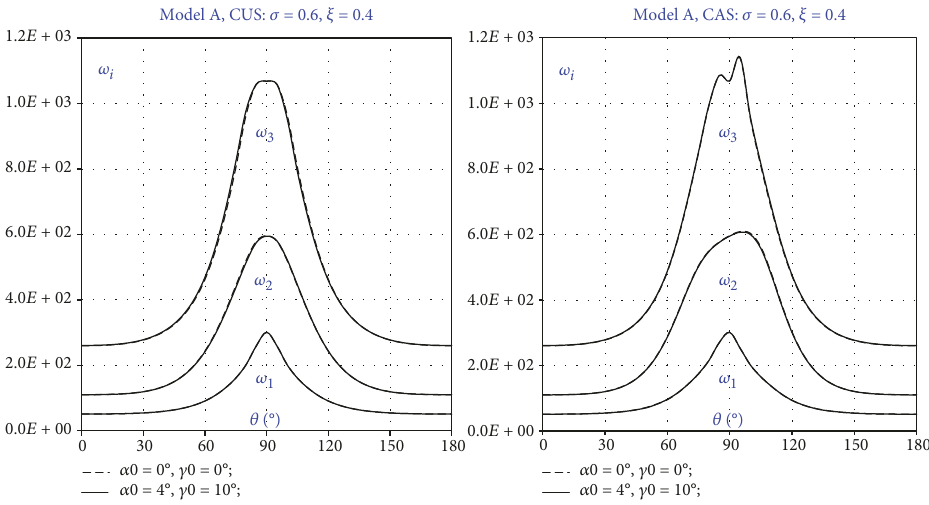
Figure 10: Eigenfrequencies vs. ply angle of Model A via α Table 7: Eigenfrequencies of Model A via α